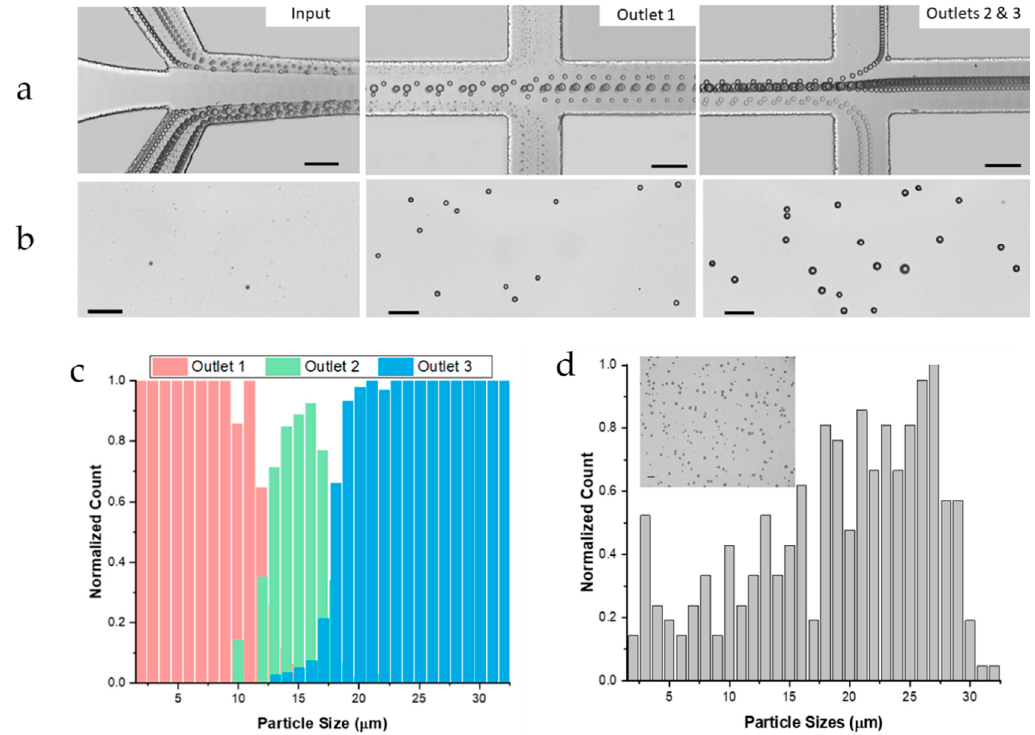
Figure 2. Separation of a continuous particle sample sized 2–32 μ m in diameter at 300 μ L·min -1 , 1:4 flow ratio and 0.59 resistance ratio. Scale bars indicate 100 μ m. ( a ) Bright field images at input and each outlet (1.05 μ s exposure, stack n = 800). ( b ) Outlet samples. ( c ) The percentage of particles in each outlet for each size. ( d ) Initial particle sample sizes and bright field image.